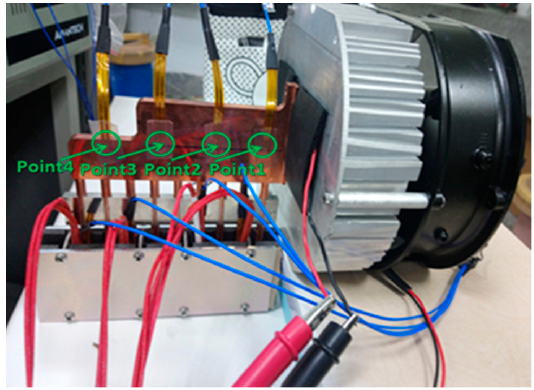
Figure 15. Measurement configuration diagram.